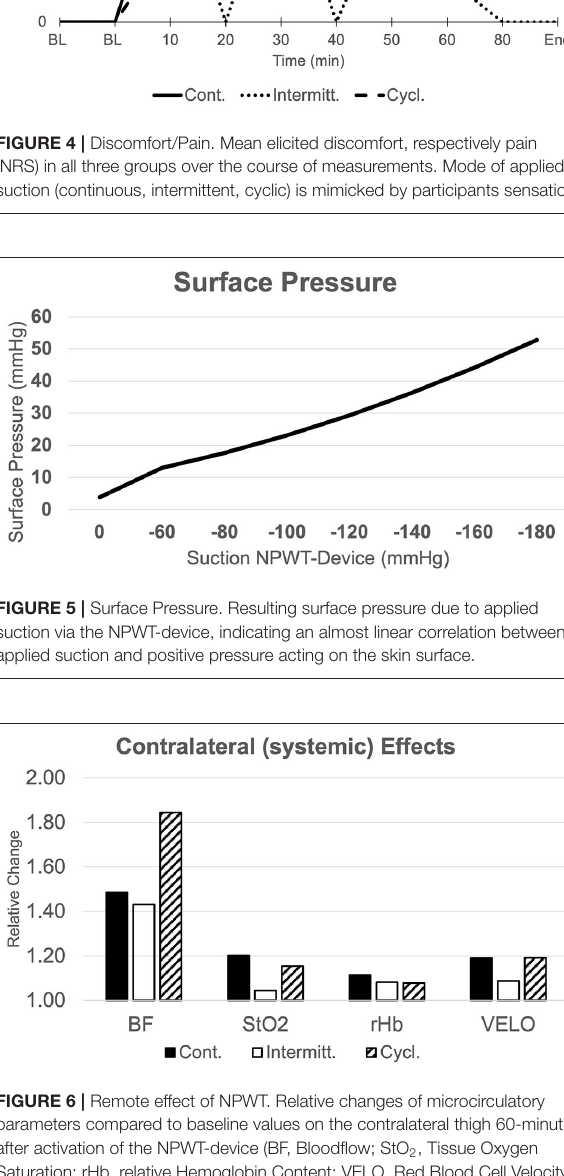
almost linear increase in surface pressure was found in relation to applied suction, which is also in line with results published earlier (10,